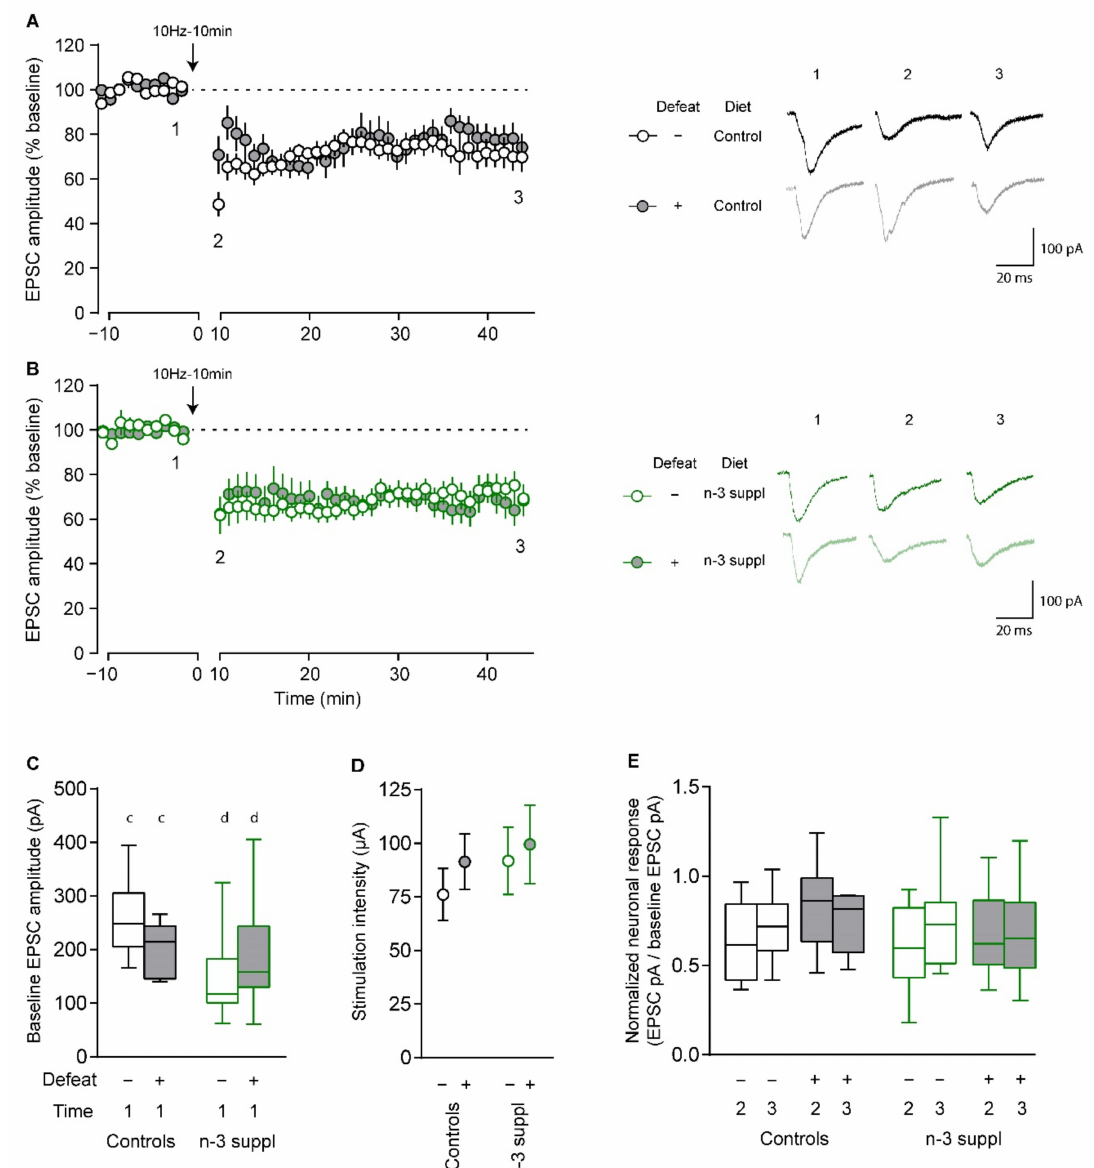
Figure 7. Reduced responses to electrical stimulation in accumbal medium spiny neurons. Represen- tative recording examples of endocannabinoid-dependent plasticity induced by 10 Hz